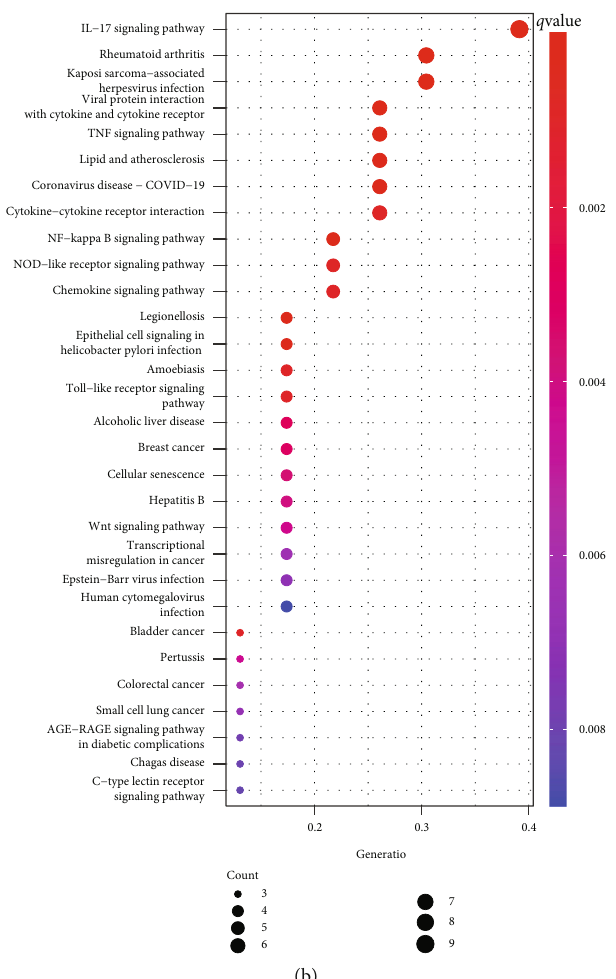
Figure 2: GO analysis (a) and KEGG analysis (b) of 44 DEGs via the ClusterPro fi